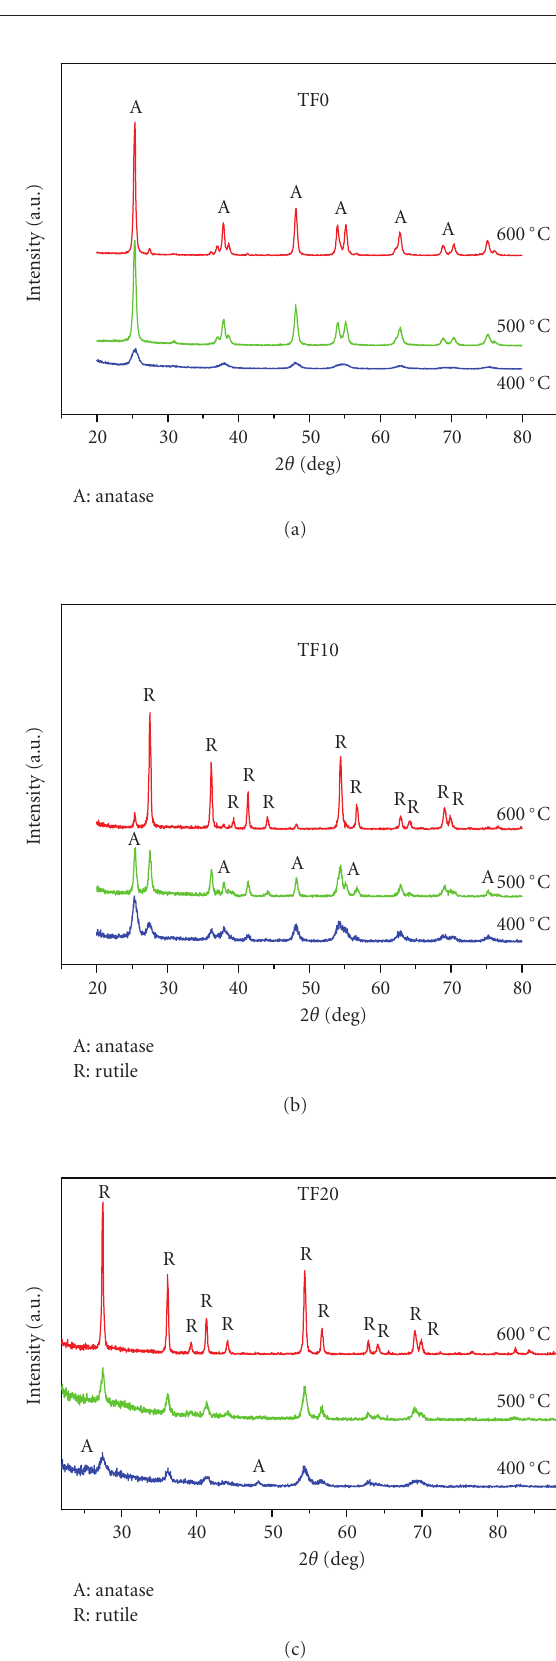
Figure 2: XRD patterns of undoped (a) and fluorinated TiO 2 pow- ders with starting ratios F/Ti = 10/90 (b) and F/Ti = 20/80